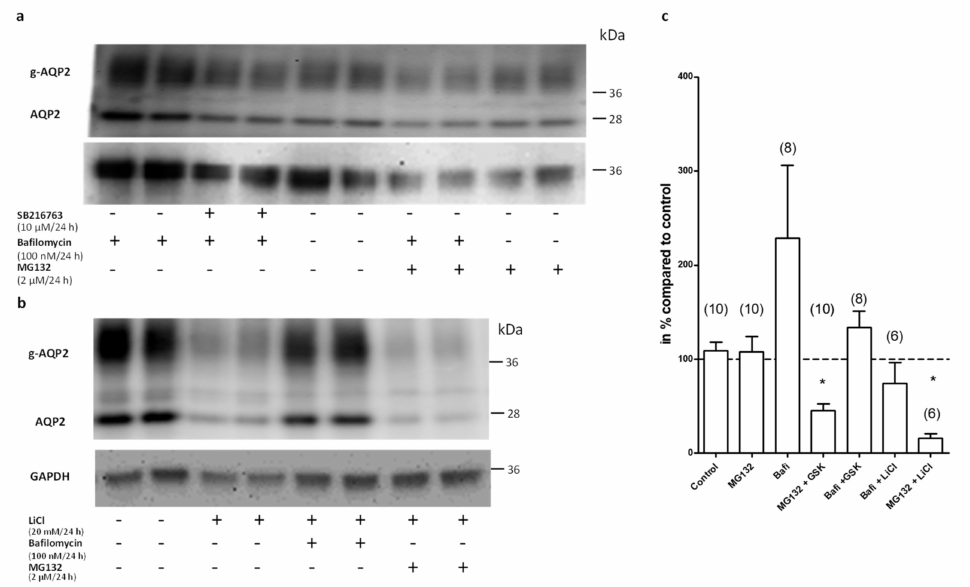
Figure 8. MG132 and bafilomycin alone had no e ff ect on Aqp2 protein expression. The expression of Aqp2 in IMCD cells treated with bafilomycin (Baf., 100 nM / 24 h), MG132 (2 µ M / 24 h), and in combination with SB216763 (GSK, 10 µ M / 24 h) was analyzed by Western blot ( a ). In the same way, the expression of Aqp2 in IMCD cells treated with bafilomycin (Baf. 100 nM / 24 h), MG132 (2 µ M / 24 h), and in combination with LiCl (20 mM / 24 h) was analyzed ( b ). The signal intensities were densitometrically analyzed and the relative changes in Aqp2 expression compared to untreated cells were calculated using GAPDH for normalization ( c ). One-way ANOVA analysis with Tukey post-test; * indicates statistically significant di ff erences to untreated control cells ( p ≤ 0.05 The number in brackets indicate the numbers of performed experiments.